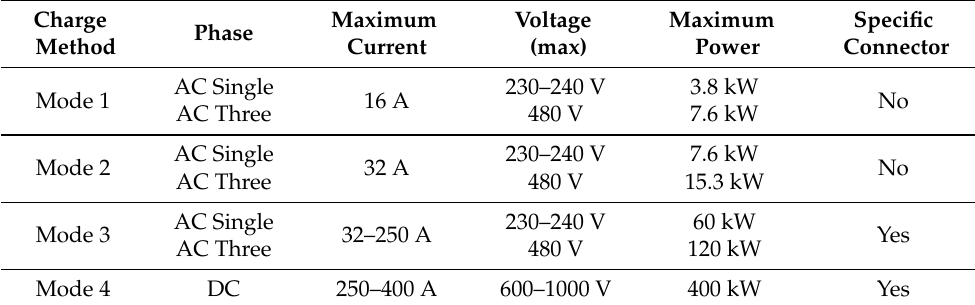
Table 5. Charge ratings of the IEC-62196